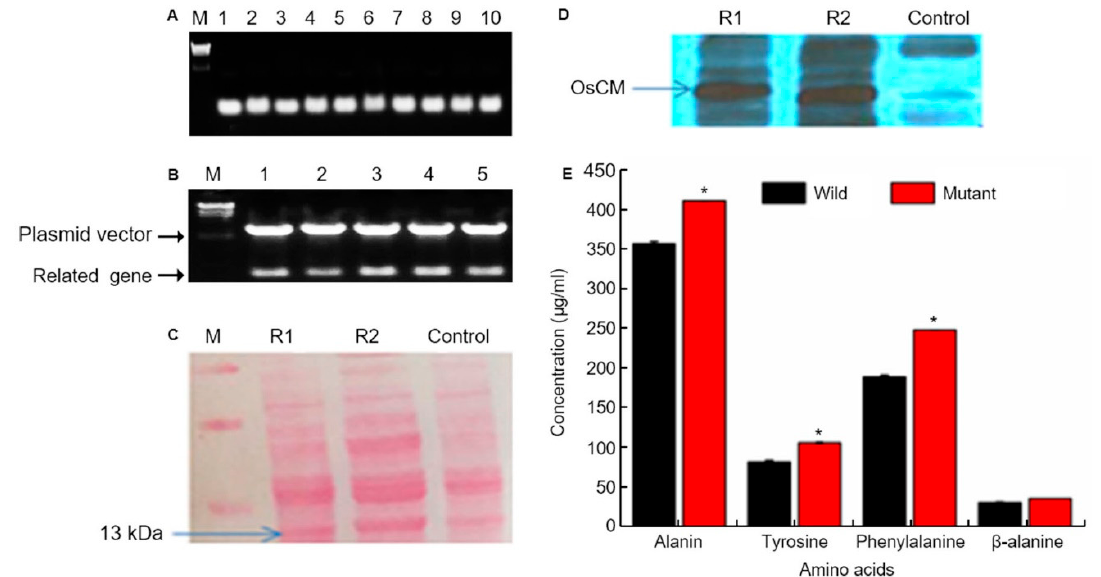
Figure 3. Chorismate mutase (CM) molecular analysis. ( A ) Colony PCR of 10 selected colonies of transformed yeast on the 0.8% agarose gel. And target gene size is 378bp. Lane; numbers 1 to 10 represent the selected colony number. M; λ / Hin dIII DNA ladder. ( B ) Confirmation of cloning and transformation of the gene of interest in Escherichia coli through restriction enzyme cutting. The upper band represents the vector, whereas the lower band shows the target gene size (378 bp). ( C ) Western blot confirmation of CM expression in yeast. Similar amounts of protein (20 µg) isolated from transformed yeast strain and control strain after 60 h. Following 12% SDS-PAGE, the gels were stained with Coomassie blue and treated with an antibody for the recombinant protein. ( D ) R1 and R2 represent OsCM replicate 1 and 2, respectively, which is the transformed strain, and the control is the wild type strain. The recombinant protein of the transformed strain is significantly expressed as compared with the wild type. ( E ) Alanine, tyrosine, phenylalanine and alanine biochemical analysis. The wild type is a control strain, and the mutant is transformed with the CM gene. * Significantly different at the 0.05